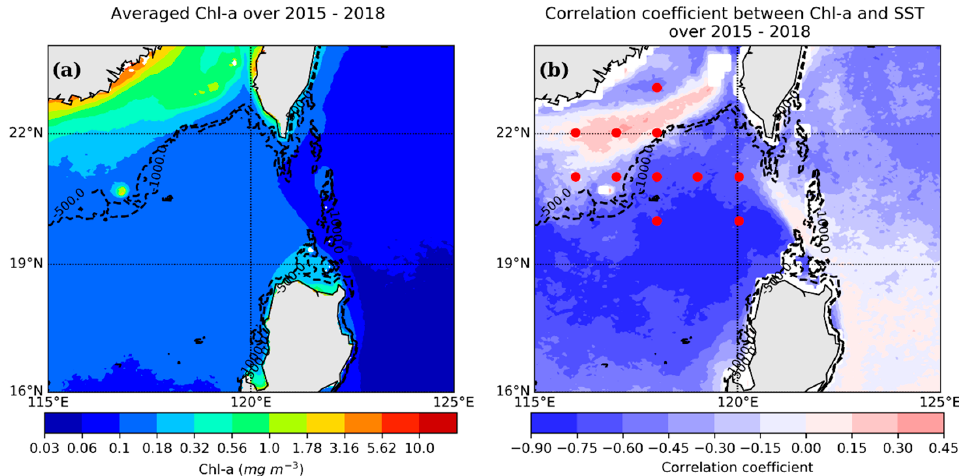
Figure 2. ( a ) Averaged Chl- a for 2015 to 2018 using valid pixels; ( b ) the correlation coefficient between Chl- a and SST over 2015–2018. The red circles represent sampling stations, and the dotted lines are the bathymetric contours of − 500 m and − 1000 m.